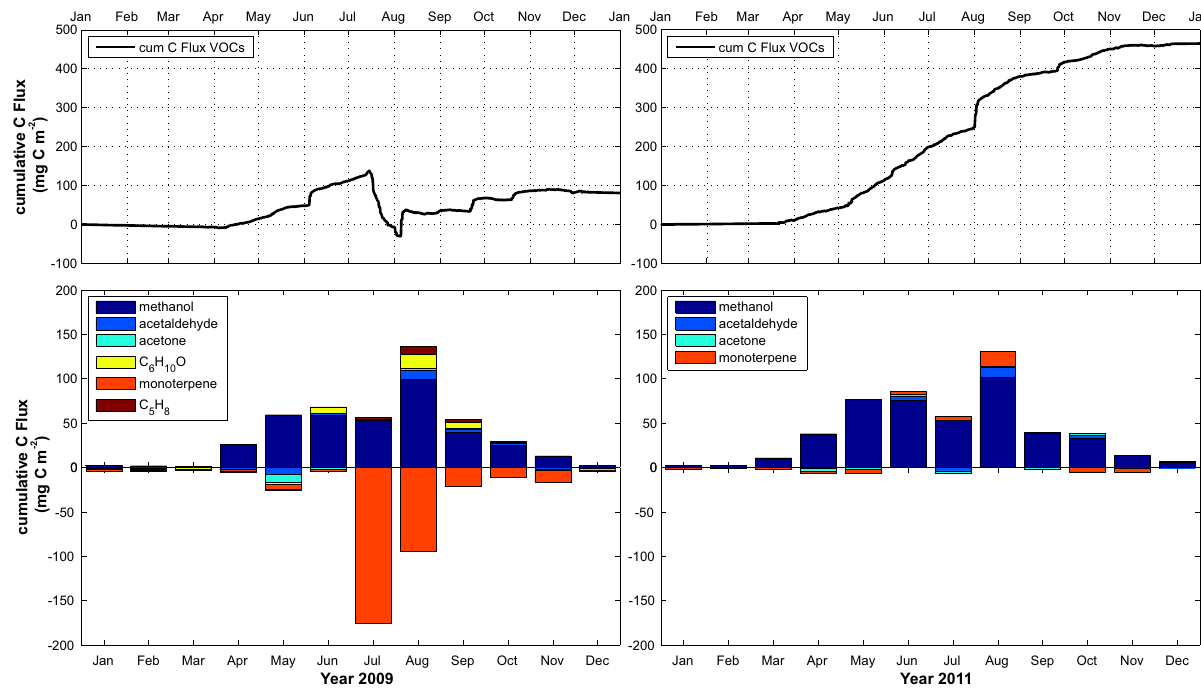
Fig. 4. Time series of the total VOC cumulative carbon flux (upper panels) and the monthly cumulative carbon (C) fluxes (lower panels) for methanol (dark blue), acetaldehyde (blue), acetone (cyan), hexenal C 6 H 10 O (yellow), monoterpenes (red), and C 5 H 8 (bordeaux) for the years 2009 (left panels) and 2011 (right